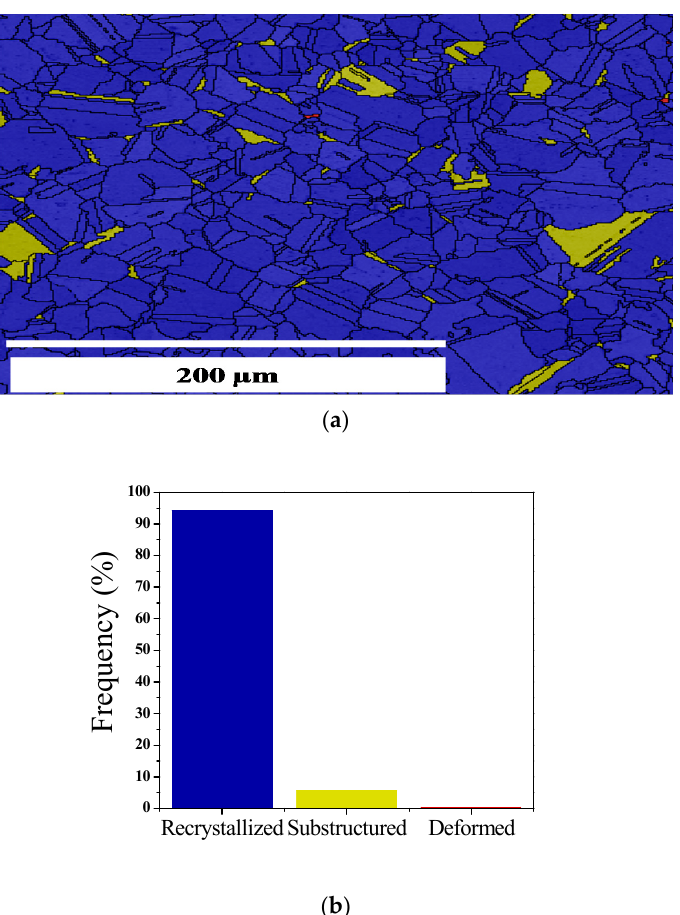
Figure 3. Recrystallized fraction for a sample with delta-processing treatment without deformation: ( a ) recrystallized grains (blue), substructured grains (yellow), deformed grains (red); ( b ) frequency (in %).